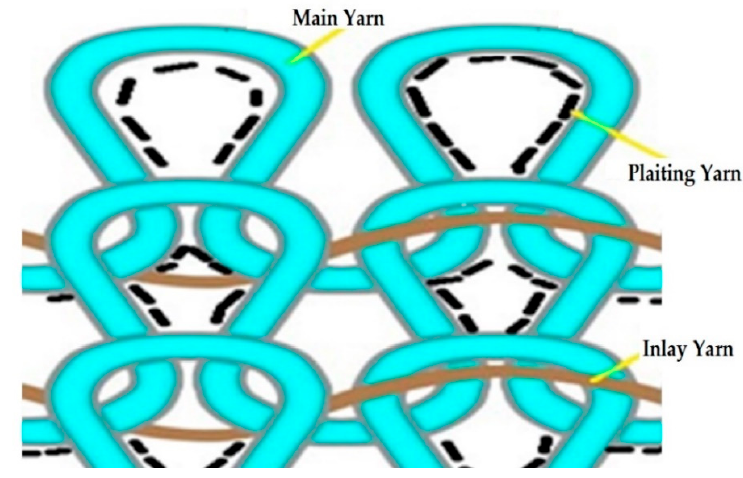
Figure 1. All yarns were imported from China. Table 1. Yarn specifications.